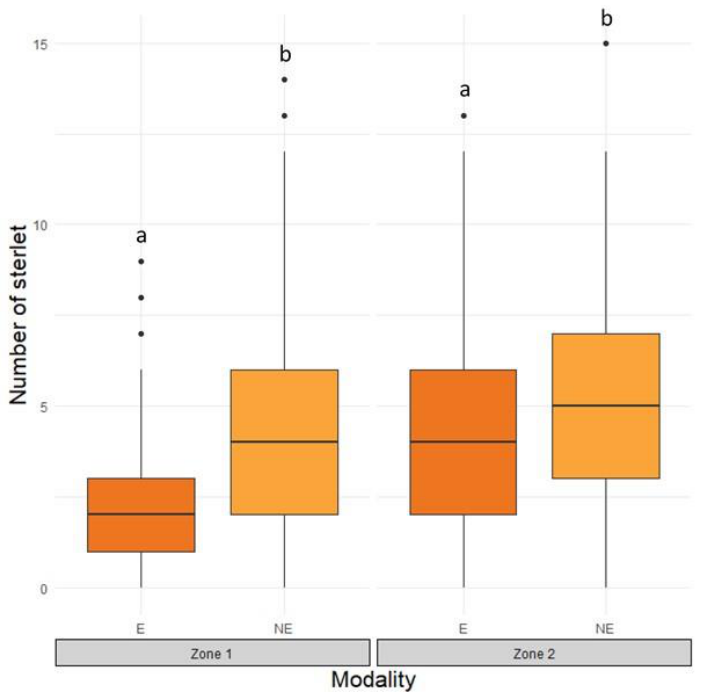
Figure 4. Median (quartiles) of sterlet numbers in the zones (1 and 2). Two different letters mean a significant difference ( p < 0.05). E: enrichment, NE: no